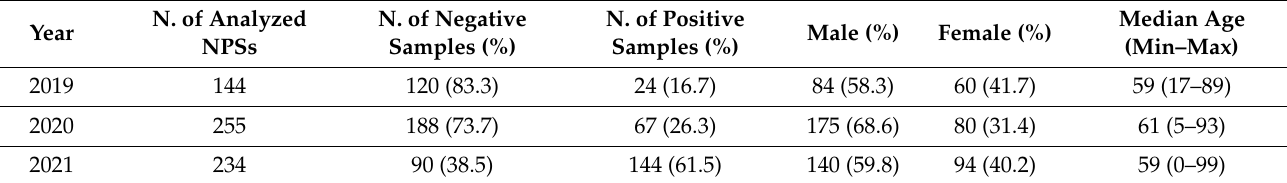
Table 1. Brief description of the NPS samples